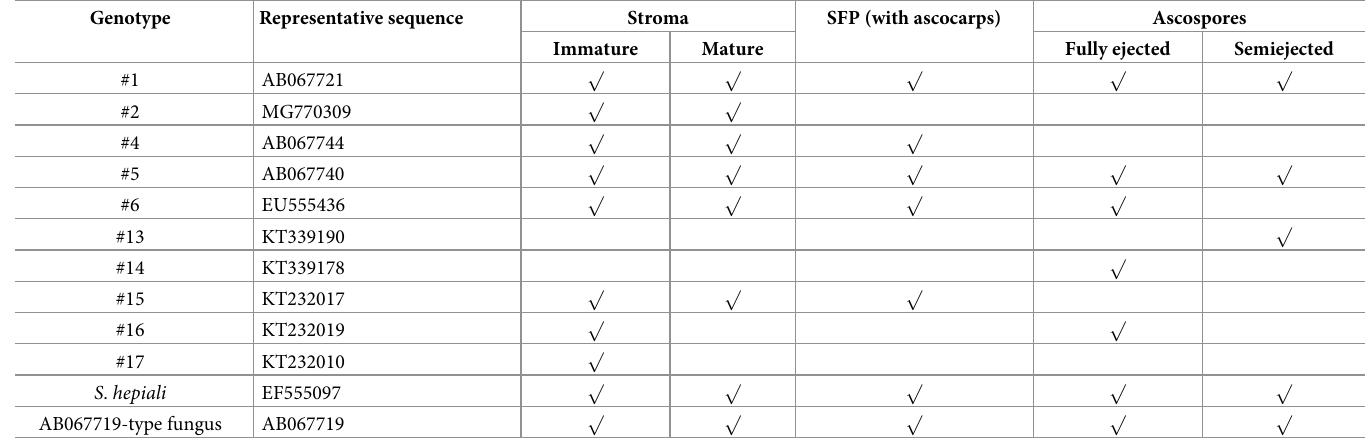
Table 2. Differential occurrence of multiple genotypes of O . sinensis , S . hepiali and AB067719-type fungus in the compartments of natural C . sinensis .